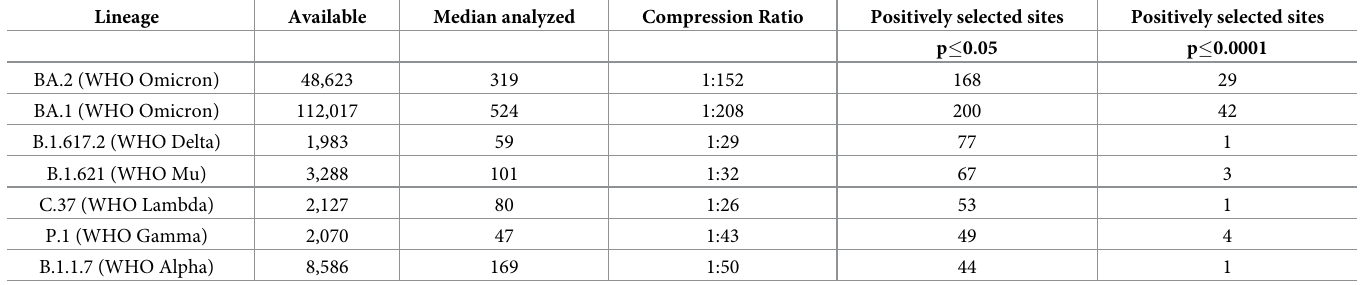
Table 1. Examples of various recent RASCL analyses on variants of interest and variants of concern for SARS-CoV-2. Full results, and more recent updates, are avail- able through our interactive notebooks (see Methods section for additional details). The lower compression ratios for Omicron reflects the higher genomic variability of this lineage, which gave rise to many sublineages soon after emergence, combined with a high-volume of viral genome